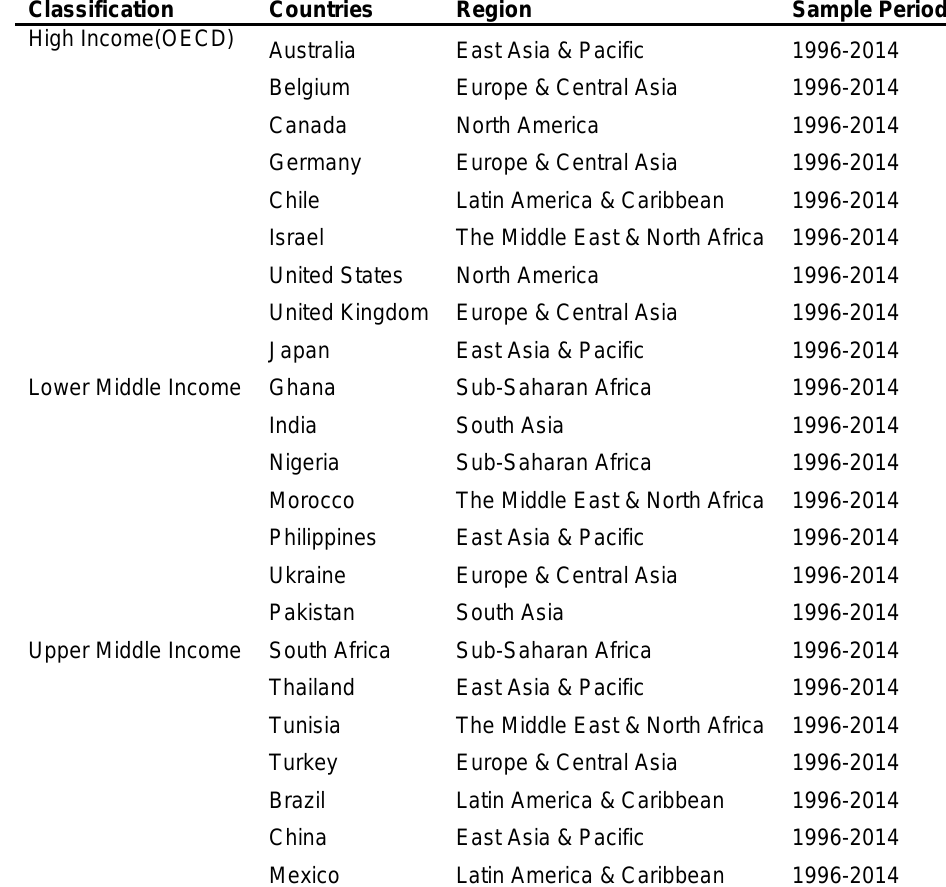
Table 1. List of countries included in the sample by income classification